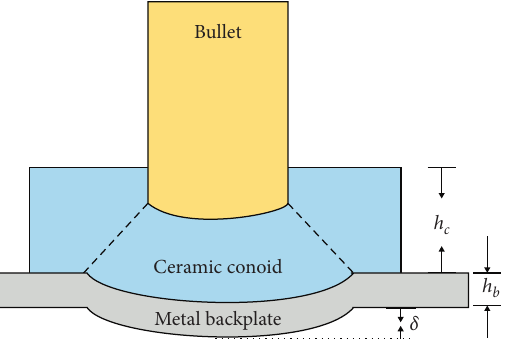
Figure 4: Velocity field analysis model.